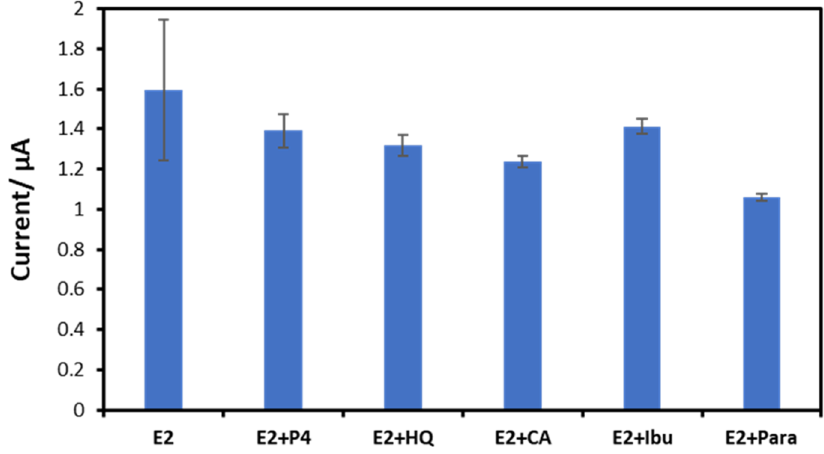
Figure 9. Effects of interferents that coexist in water on detecting estradiol. The initial concentration of target and interference (analyte:interferent) was 1:10 (µM/µM).